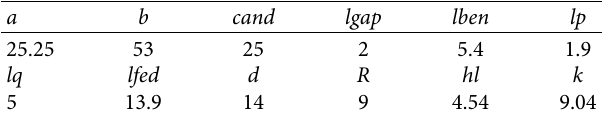
Table 3: Parameters of antenna 3 (mm).